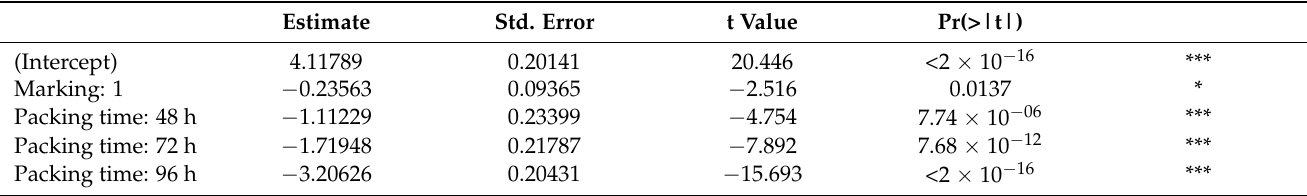
Table 5. Fixed effects of the effects of marking (1 = marked vs. 0 = unmarked), irradiation and transport duration (packing times: 48 h, 72 h and 96 h vs. 24 h) on the escape rate of Aedes aegypti , Brazil strain, in laboratory conditions.